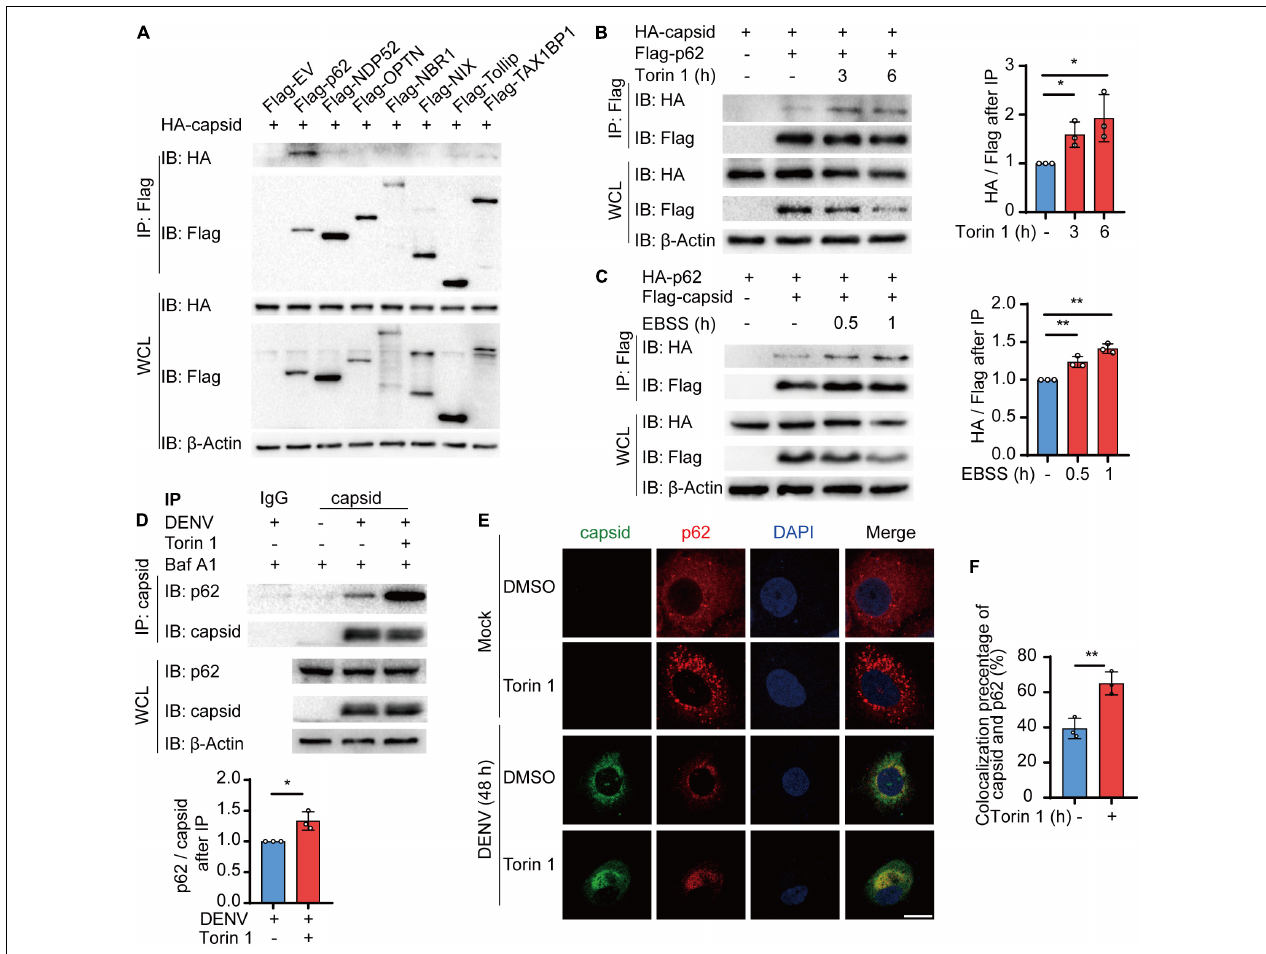
FIGURE 3 | Cargo receptor p62 interacts with dengue virus (DENV) capsid protein during viral infection. (A) 293T cells were transfected with plasmids encoding HA-C protein and indicated Flag-tagged cargo receptors, followed by immunoprecipitation (IP) with anti-Flag beads and immunoblot analysis with anti-HA. (B) Coimmunoprecipitation and immunoblot analysis of 293T cells transfected with plasmids expressing HA-C protein and Flag-p62 with 2 µ M Torin 1 treatments for indicated time points. The ratios between HA and Flag after immunoprecipitation were analyzed. (C) Coimmunoprecipitation and immunoblot analysis of 293T cells transfected with plasmids expressing HA-p62 and Flag-C protein with earle’s balanced salt solution (EBSS) treatments for indicated time points. The ratios between HA and Flag after immunoprecipitation were analyzed. (D) Coimmunoprecipitation and immunoblot analysis of Huh7 cells infected with DENV for 48 h followed by Torin 1 and Baf A1 treatments. The ratios between p62 and C protein after immunoprecipitation were analyzed. (E) Confocal microscopy of Huh7 cells infected with DENV (MOI = 0.5) for 24 h and treated with Torin 1 (2 µ M) for 6 h, followed by labeling of C protein and p62 with specific primary antibody and a CF568 goat anti-mouse IgG secondary antibody (red) and Alexa Fluor 488 conjugated anti-rabbit-IgG secondary antibody (green). Scale bar, 10 µ m. (F) Pearson’s correlation coefficients of DENV C protein and p62 in (E) . Data represent replicate measurements in at least 10 cells from three independent experiments. Data in (A–D,F) are expressed as mean ± SEM of three independent experiments. * p < 0.05, ** p < 0.01 (two-tailed Student’s t -test). All the experiments are representatives of three independent biological experiments with similar results.